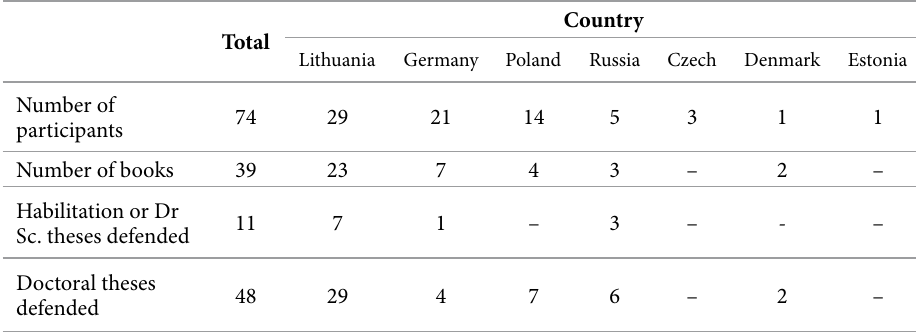
Table 1. Number of participants, books, defended Habilitations (Dr Sc) and Doctoral theses